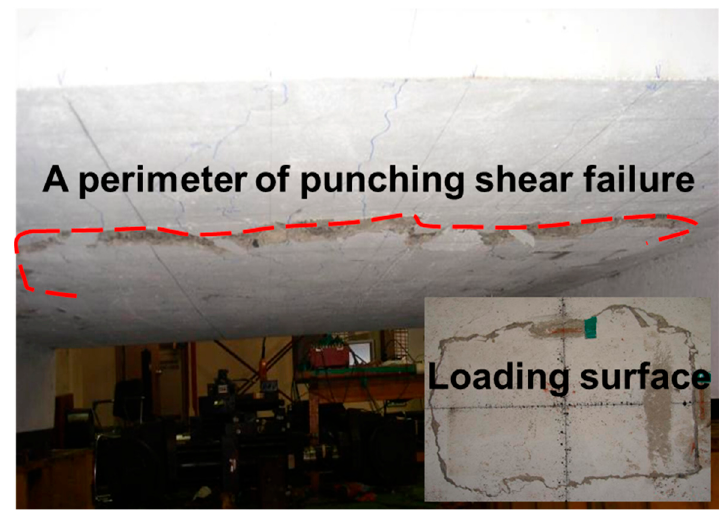
Figure 3. Punching shear failure at the bottom surface.